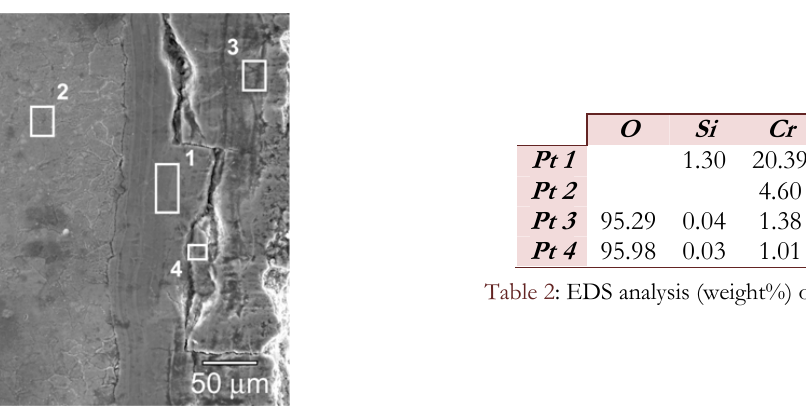
Figure 15: SEM analysis. Internal area of pipe where protective scale layer is still present, even if very thin; the scale appears damaged and penetrated, so that a relevant fracture is present. – 400